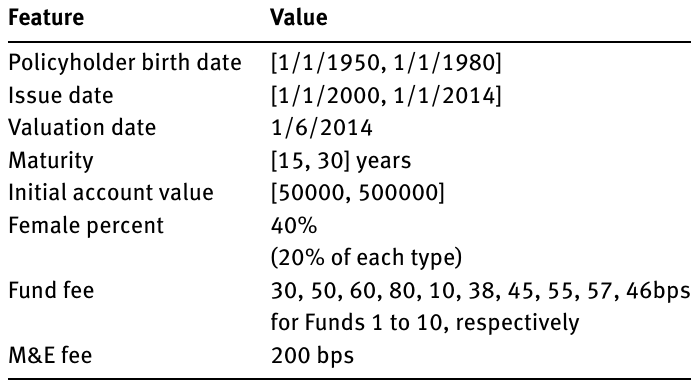
Table 3: Parameter values used to generate the synthetic